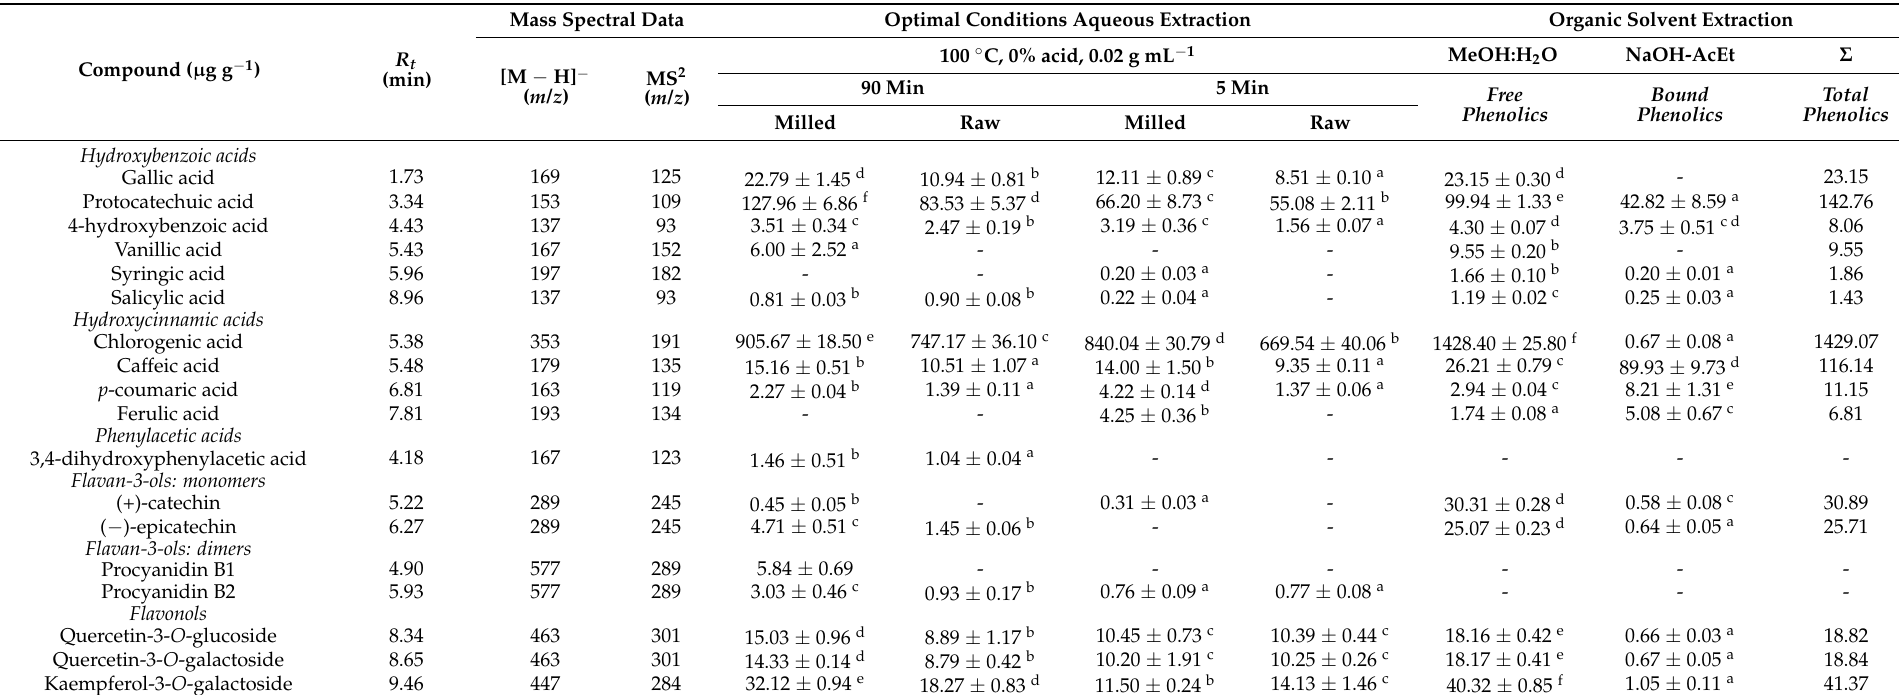
Table 6. UPLC-ESI-MS/MS phenolic compounds profile of the coffee husk extracts obtained by the aqueous extraction using optimal conditions and the organic solvent extraction of the free and bound phenolic